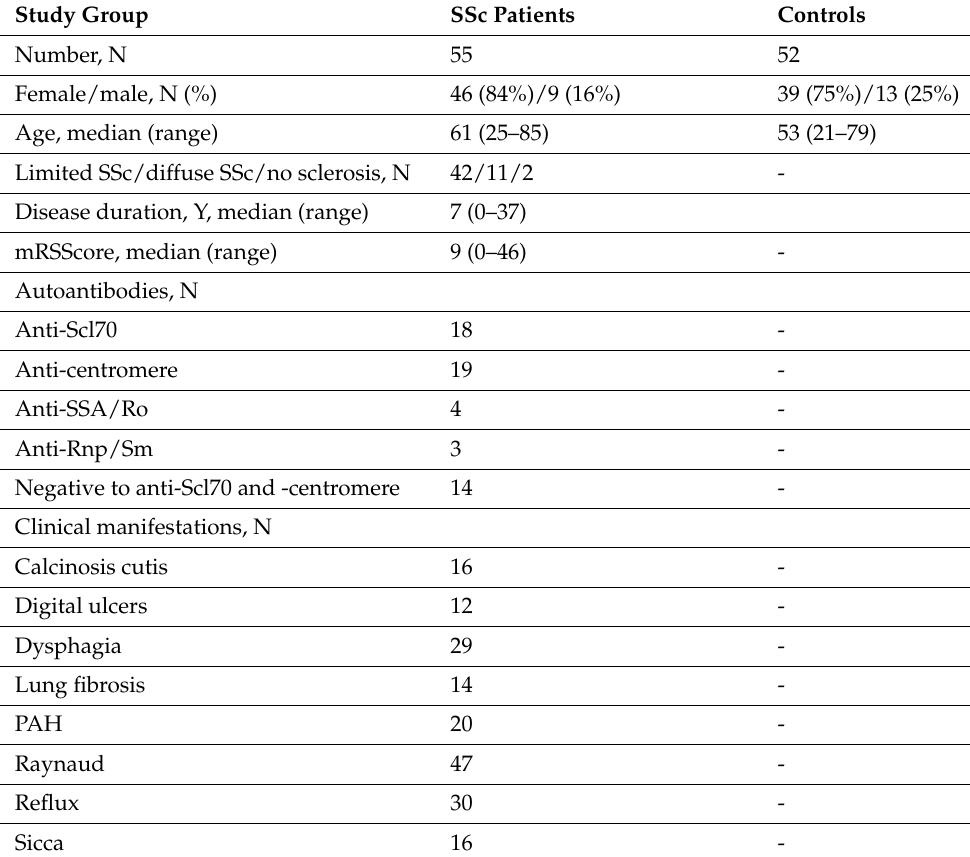
Figure 1. Autoantibody load in SSc patients with lung and skin fibrosis. The box plots show the increase in the number of autoantibodies per sample (autoantibody load) in SSc patients with ( a ) mRSS > 15 or lung fibrosis, and particularly in ( b ) SSc patients presenting both mRSS > 15 and lung fibrosis. Herein, p -values refer to the ( a ) Mann–Whitney–Wilcoxon and ( b ) Kruskal–Wallis tests; p < 0.05, cutoff for significance; mRSS: Modified Rodnan skin score; LF: Lung fibrosis. Table 1. Study group: Clinical characteristics and clinical autoantibody status.